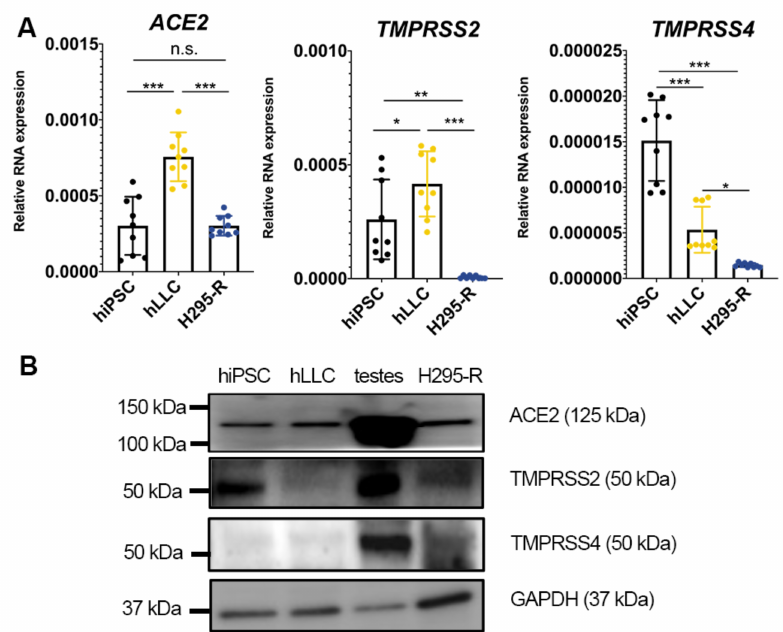
Figure 2. Human testes and human Leydig-like cells (hLLCs) have receptors pivotal for SARS-CoV-2 entry. ( A ) SARS-CoV-2 spike protein receptor ACE2 mRNA is highly expressed in human-induced pluripotent stem cells (hiPSCs), hiPSC-derived hLLCs, and H295-R human adrenal cortical cells. The SARS-CoV-2 spike protease TMPRSS2 mRNA is highly expressed in iPSCs, and hLLCs, whereas another SARS-CoV-2 spike protease TMPRSS4 mRNA is extremely low in hLLCs and H295-R. The hiPSCs used for hLLC derivation were used as controls. Data are presented as means ± SDs, n ≥ 3. Not significant = n.s. at p > 0.05; * p < 0.05; ** p < 0.01; *** p < 0.001. ( B ) ACE2 protein is expressed in hiPSCs, hLLCs, human testis lysates, and H295-R cells. TMPRSS2 and TMPRSS4 are less expressed in H295-R cells than in human testes. TMPRSS2/TMPRSS4 expression is extremely low in hLLCs,